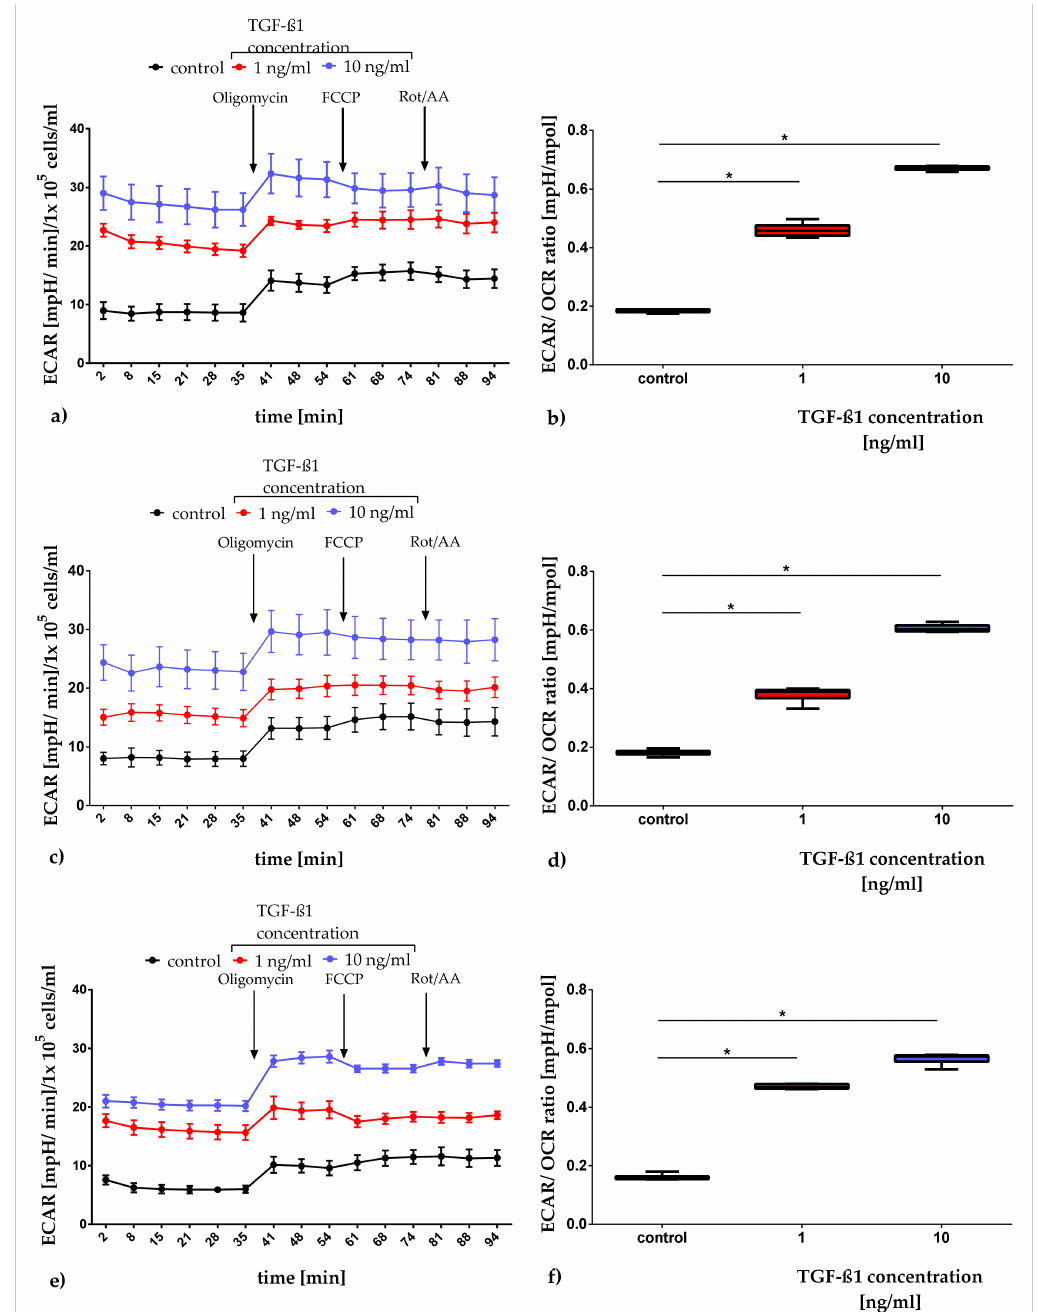
Figure A3. Quantification of the extracellular acidification rate (ECAR) after TGF-ß1 exposure on day 1 (a, b), 3 (c, d), and 7 (e, f). ECAR data are presented as a mean, with the standard error of the mean normalized to 1 x 10 5 cells / ml (a, c, e). The basal metabolism of the cultures was assessed by calculating ECAR / OCR ratios. Data were presented as box plots, with medians, interquartile ranges, and minimum / maximum values (b, d, f). Since the dataset did not represent a Gaussian distribution (Shapiro-Wilk test), the statistical analysis was performed using the One-Way ANOVA test followed by Dunnett’s multiple comparison post hoc test (n = 4). *, p -value ≤ 0.05. Comparison to the control. FCCP: carbonyl-cynaide-4 (trifluoromethoxy) phenylhydrazone; Rot / AA: rotenone / antimycin A; ATP: adenosine triphosphate; max.: